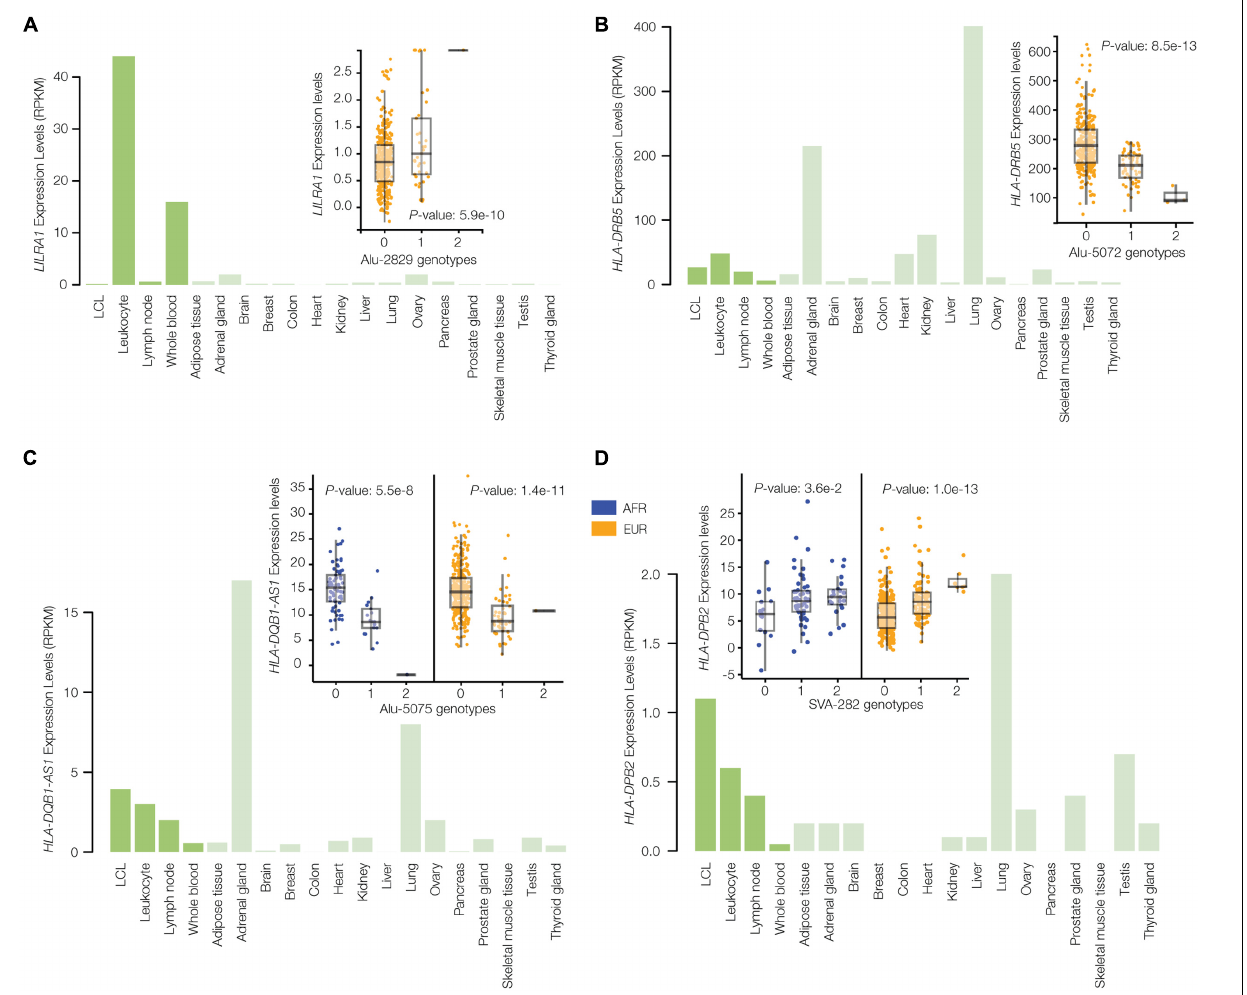
FIGURE 6 | Gene expression profiles and eQTL results for disease-associated polyTE insertions. Bar-charts of tissue-specific expression levels and box-pots of eQTL analyses are shown for four examples of TE-eQTLs corresponding to disease-linked and enhancer co-located polyTE insertions that regulate immune-related genes: (A) Alu-2829 and LILRA1 , (B) Alu-5072 and HLA-DRB5 , (C) Alu-5075 and HLA-DQB1-AS1 , and (D) SVA-282 and HLA-DPB2 . Bar-charts show tissue-specific expression levels as normalized RPKM values (green). The inset eQTL box-plots show individual sample gene expression levels ( y -axis) regressed against polyTE insertion presence/absence genotypes ( x -axis): 0-homozygous absent, 1-heterozygous, 2-homozygous present. Each dot represents a single individual from the African (AFR – blue) and/or European (EUR – orange) population